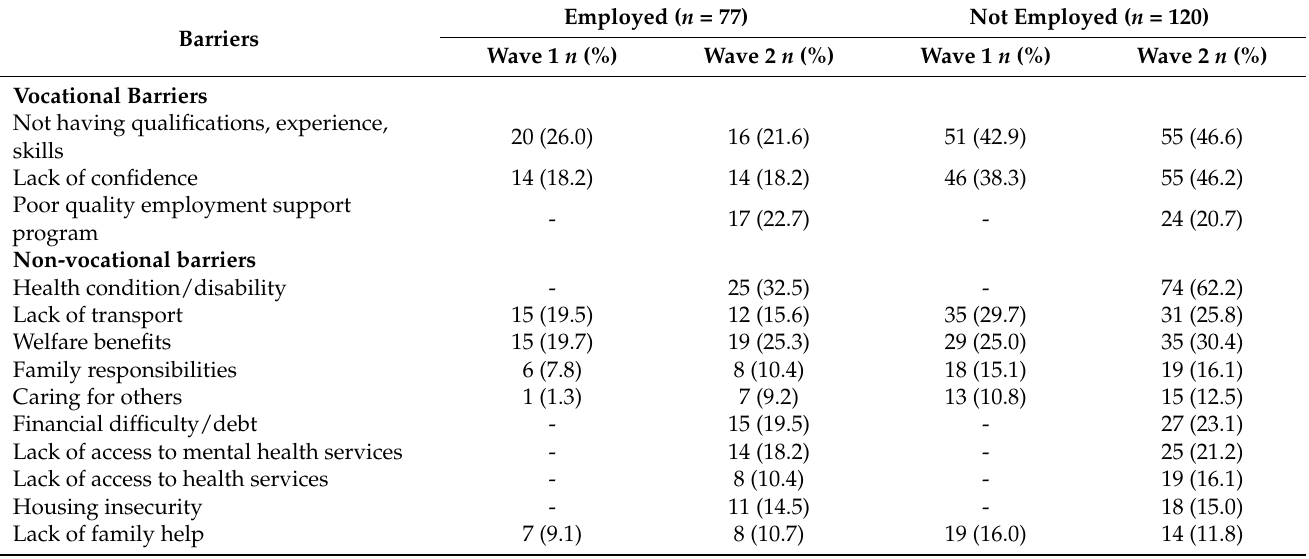
Table 2. Wave 1 and 2 barriers greatly affecting ability to find and maintain work, by Wave 2 employment